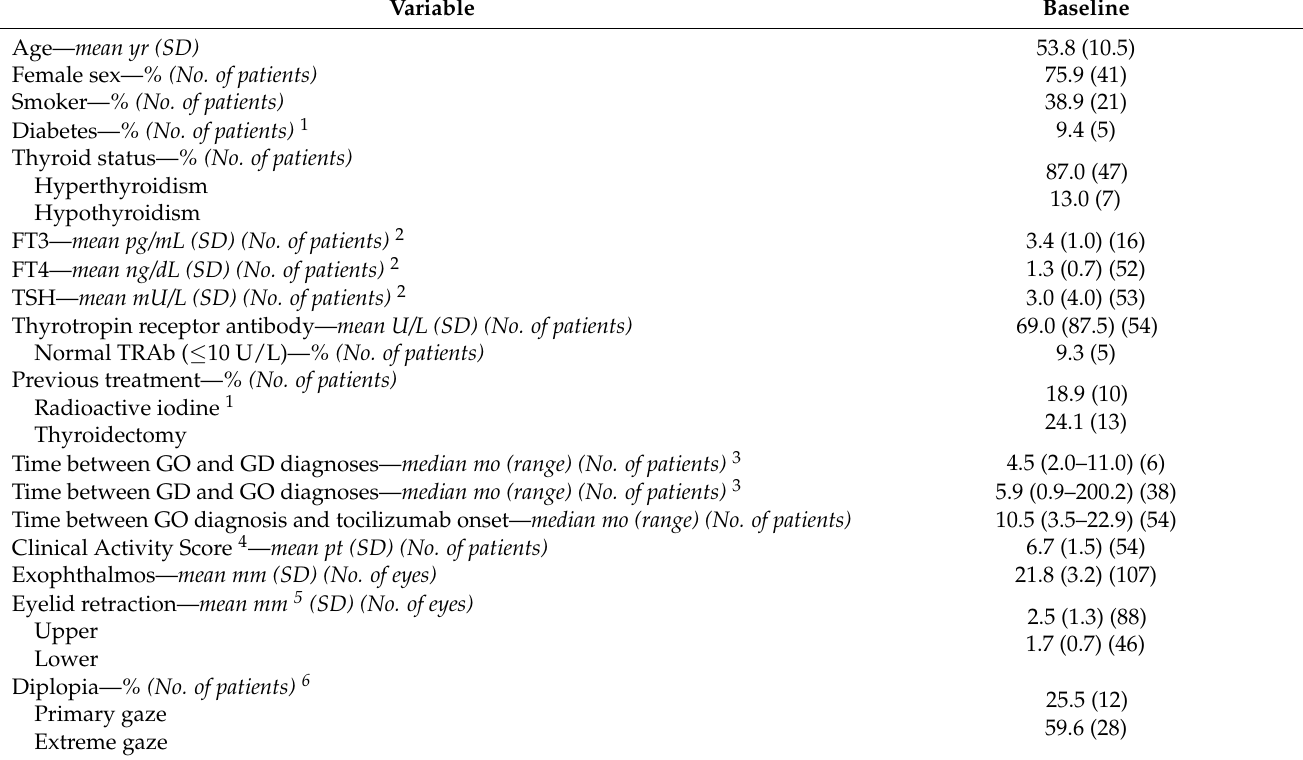
Table 1. Baseline characteristics of the